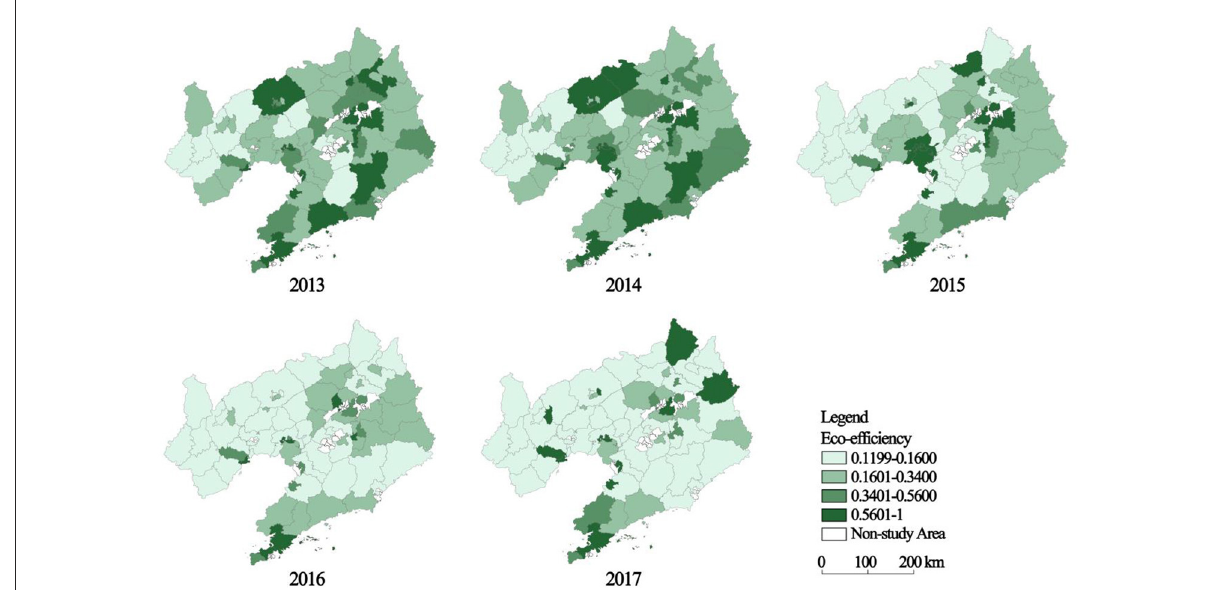
FIGURE3 Spatial pattern of eco-efficiency in agricultural counties and districts of Liaoning province (2013–2017).